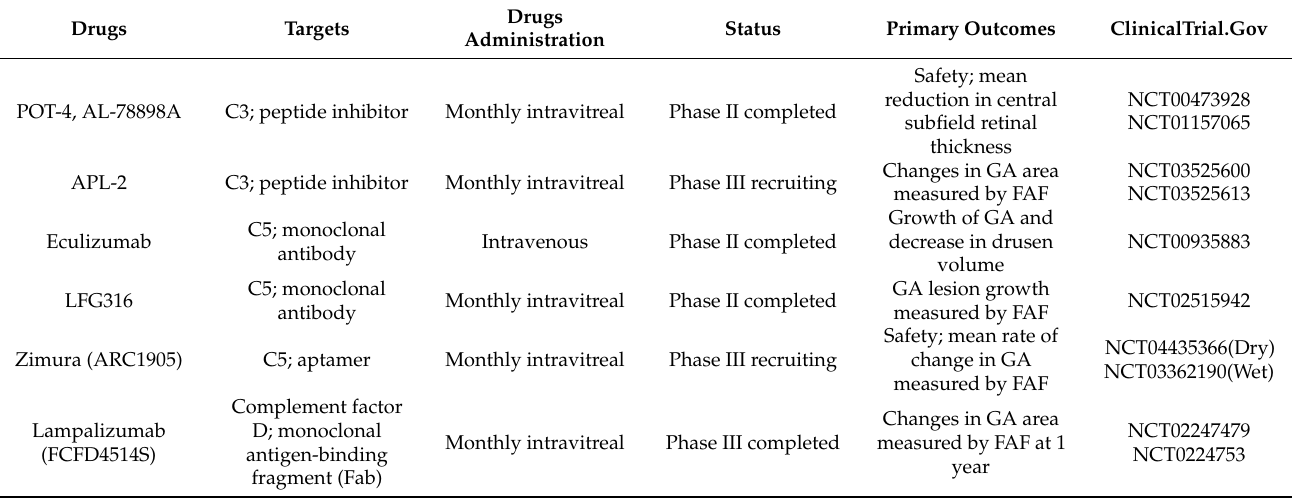
Table 2. Noteworthy complement therapeutics in clinical